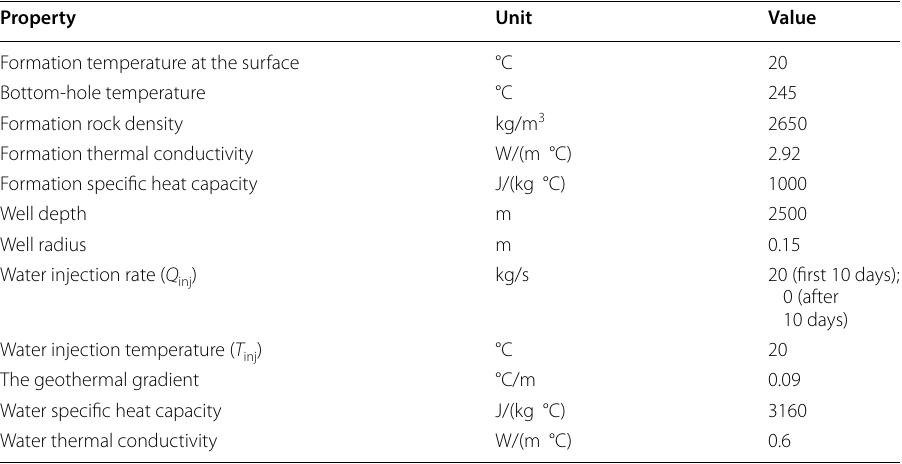
Table 2 Geometry and material properties used in the modeling of circulation and shut-in Property Unit Value Formation temperature at the surface °C Bottom-hole